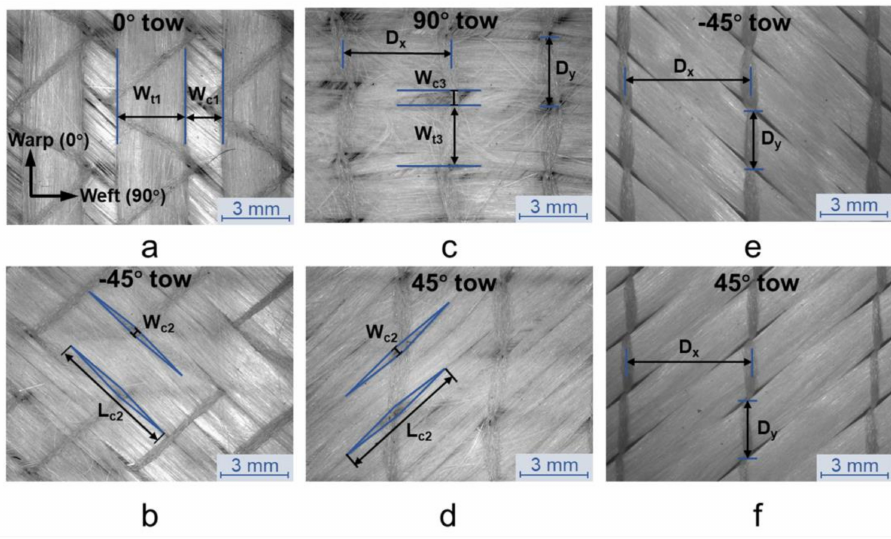
Figure 1. ( a ) Structure of fiber tows orientated at 0 ◦ in quadriaxial NCF, E-DBLT800-6 TM ; ( b ) structure of fiber piles orientated at − 45 ◦ in quadriaxial NCF, E-DBLT800-6 TM ; ( c ) structure of fiber tows orientated at 90 ◦ in quadriaxial NCF, E-DBLT800-6 TM ; ( d ) structure of fiber piles orientated at 45 ◦ in quadriaxial NCF, E-DBLT800-6 TM ; ( e ) structure of fiber tows orientated at − 45 ◦ in biaxial NCF, E-DB800 TM ; ( f ) structure of fiber tows orientated at 45 ◦ in biaxial NCF, E-DB800 TM